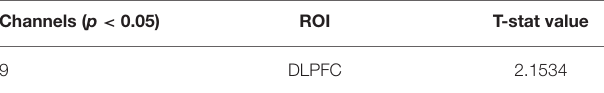
TABLE 5 | Oxyhemoglobin contrast results between GLM output of low reliability and high reliability conditions (T Low R Low + T High R Low )-(T Low R High +T High R High ). Channels ( p <